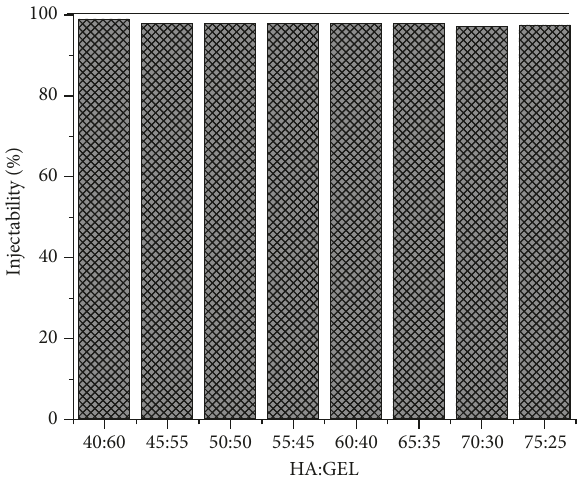
Figure 2: Injectability testing results of IBS. Figure 3: The setting time test results of IBS.